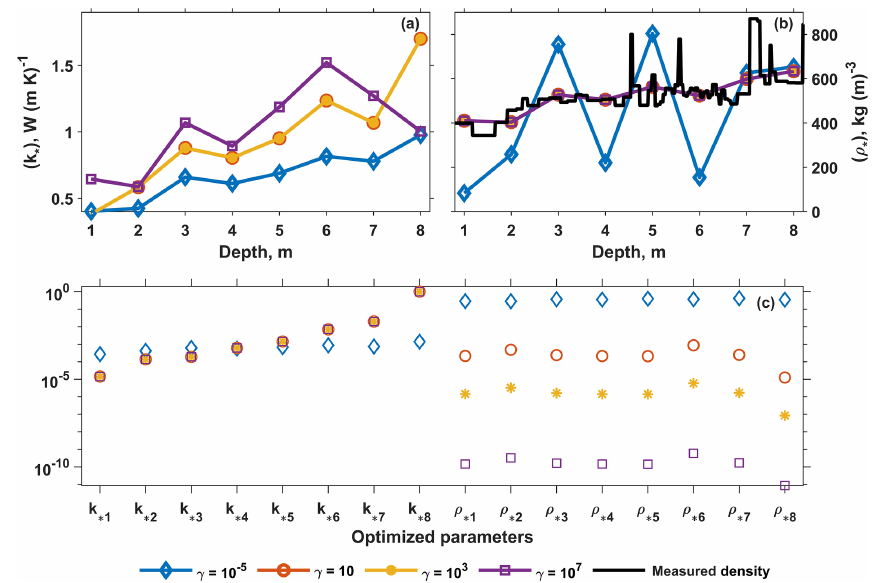
Figure 4. The optimal solutions k ∗ (a) and ρ ∗ (b) in the spring 2012 domain for different values of γ in Eq. (7). The black curve in (b) shows measured density values. (c) Absolute values of the eigenvector with the smallest eigenvalue of the Hessian H in Eq.